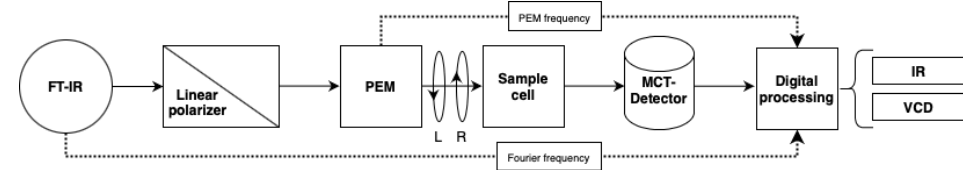
Figure 2. Block diagram of a FT-VCD spectrometer. See text for definitions of the used abbreviations.